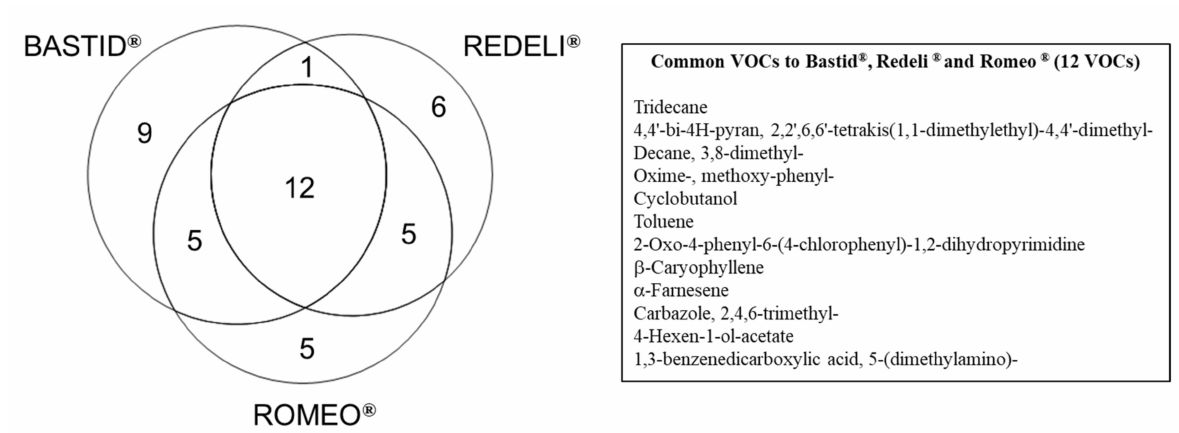
Figure 3. Venn diagram of the VOCs induced by commercial elicitors. Distribution of 43 VOCs detected with FC > 1.5 at least once at two time points or at least in two replicates for one time point (Table 2), following Bastid ® , Redeli ® or Romeo ® treatment. The 12 commonly induced VOCs are listed in the table on the